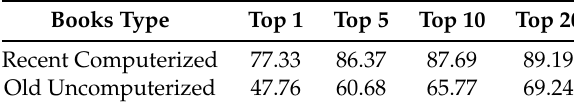
Table 4. Multi-Fonts WRR (percent) for